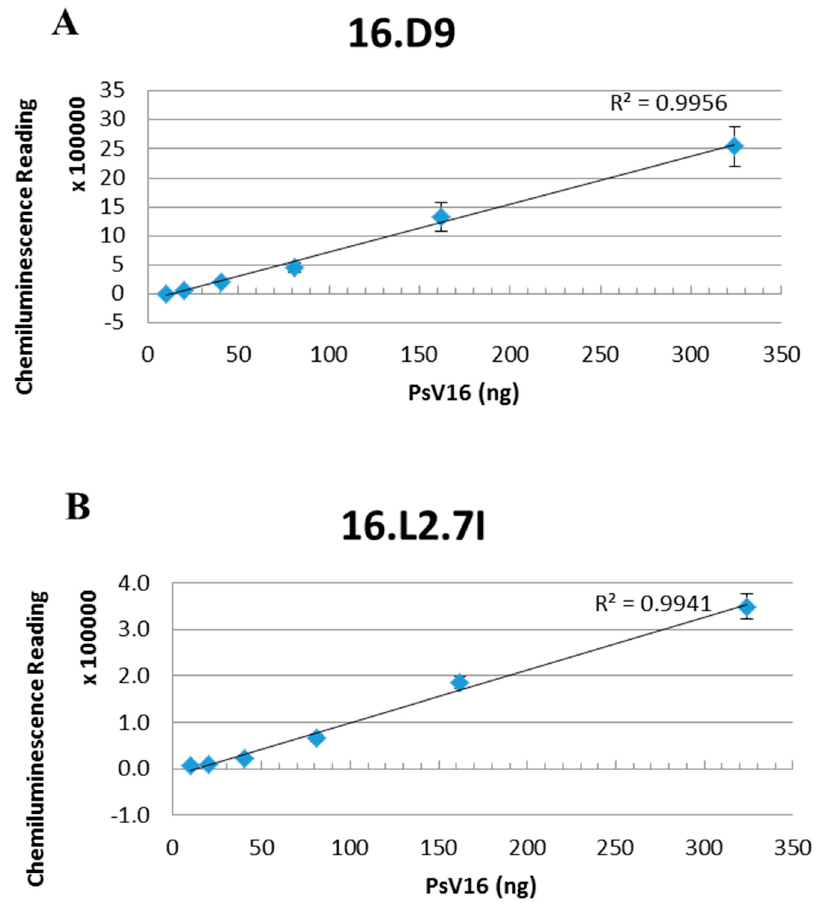
Figure 7. L2 content of PsV preparations. Denatured PsVs were serially diluted and added to the nitrocellulose membrane of the Quantitative Dot Blot (QDB) plate in quadruplicate. L1 and L2 were detected with ( A ) 16.D9 and ( B ) 16.L2.7I mAbs respectively and a secondary horseradish peroxidase HRP conjugated mAb. Plates were developed with enhanced chemiluminescence (ECL) peroxidase